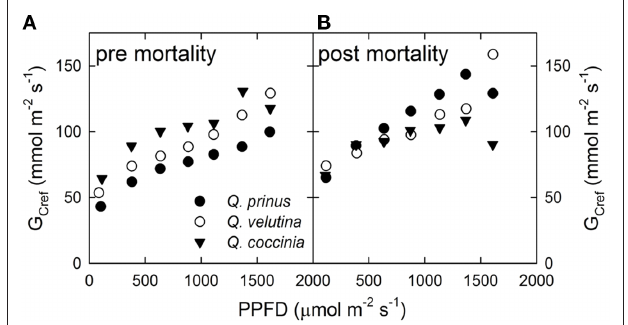
Figure 4 | reference canopy stomatal conductance ( G (PPFD) response (A) before drought and disturbance in 2005 and (B) after mortality occurred in 2008. Quercus prinus (filled circle), Q. velutina (open circle), and Q coccinea (filled triangle).